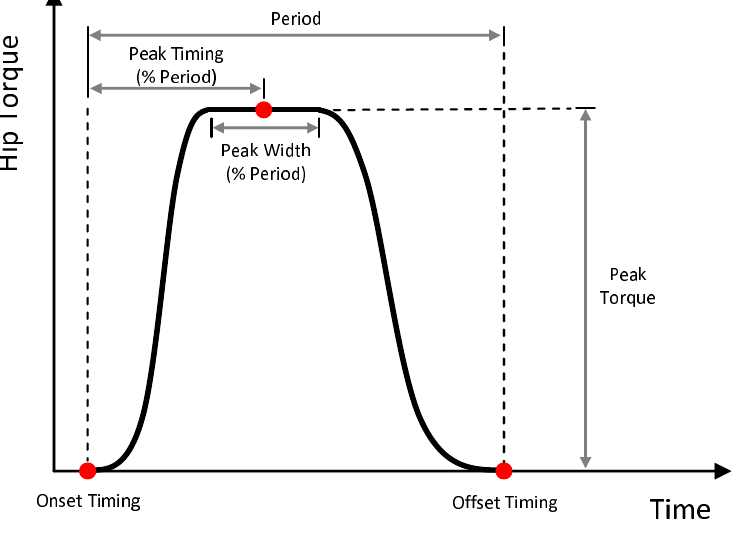
Figure 3. Hip assistive force